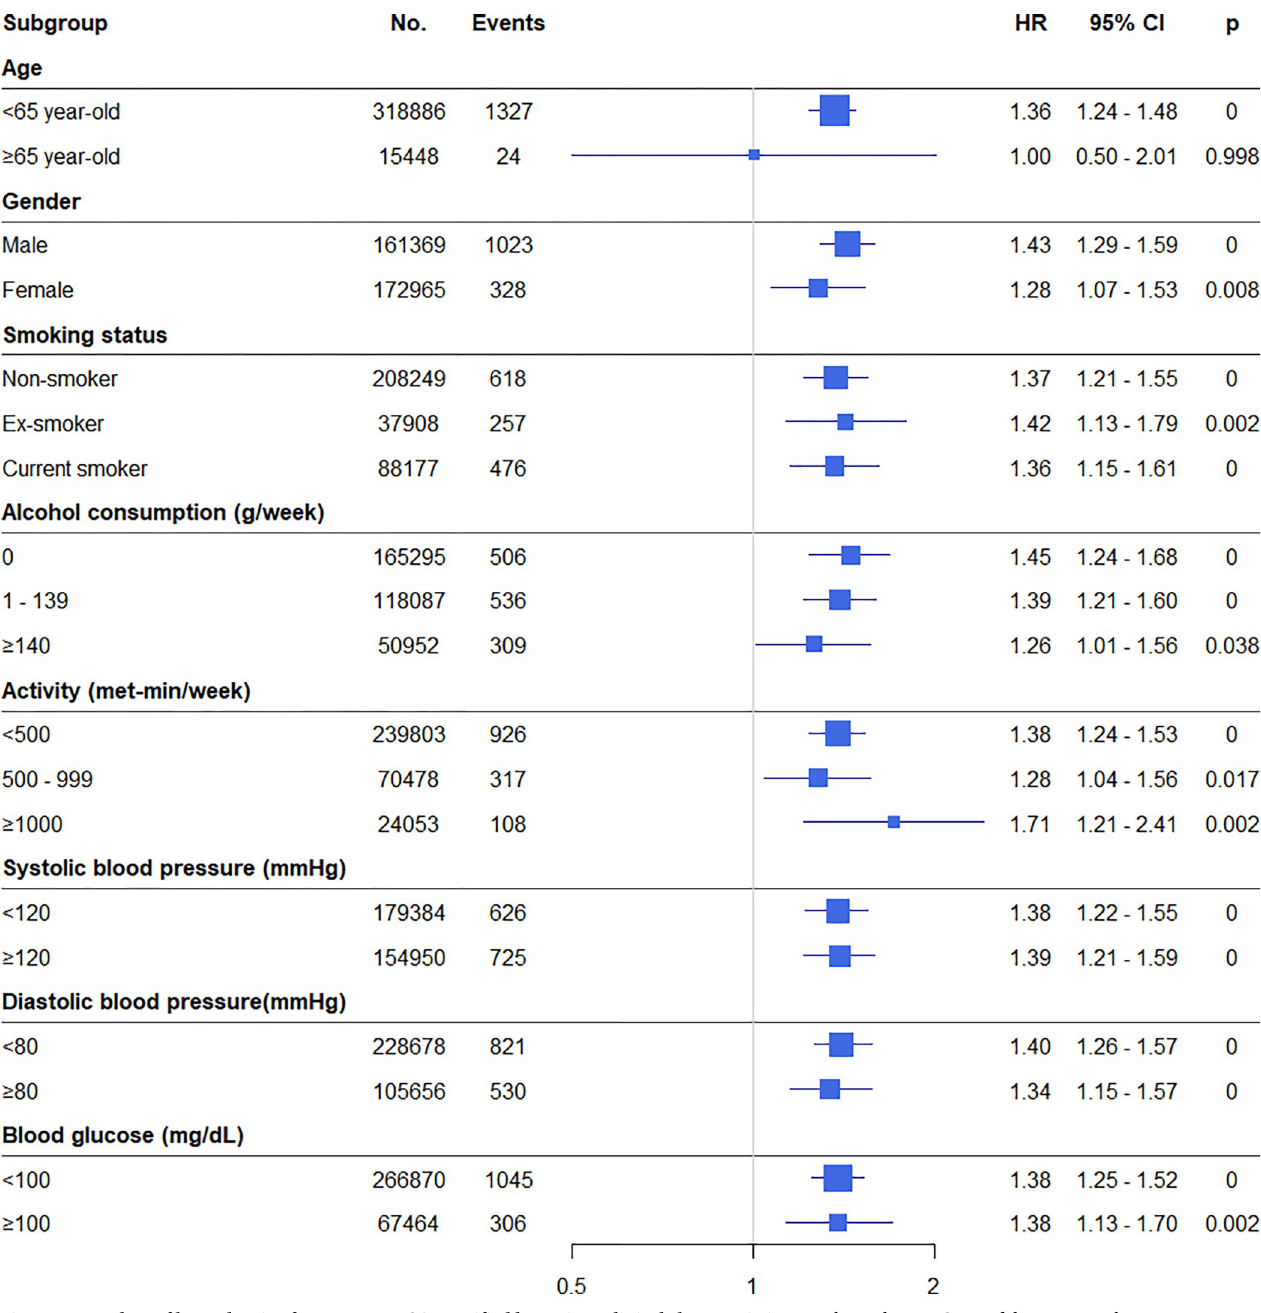
PLOS ONE | https://doi.org/10.1371/journal.pone.0271021 July 20,